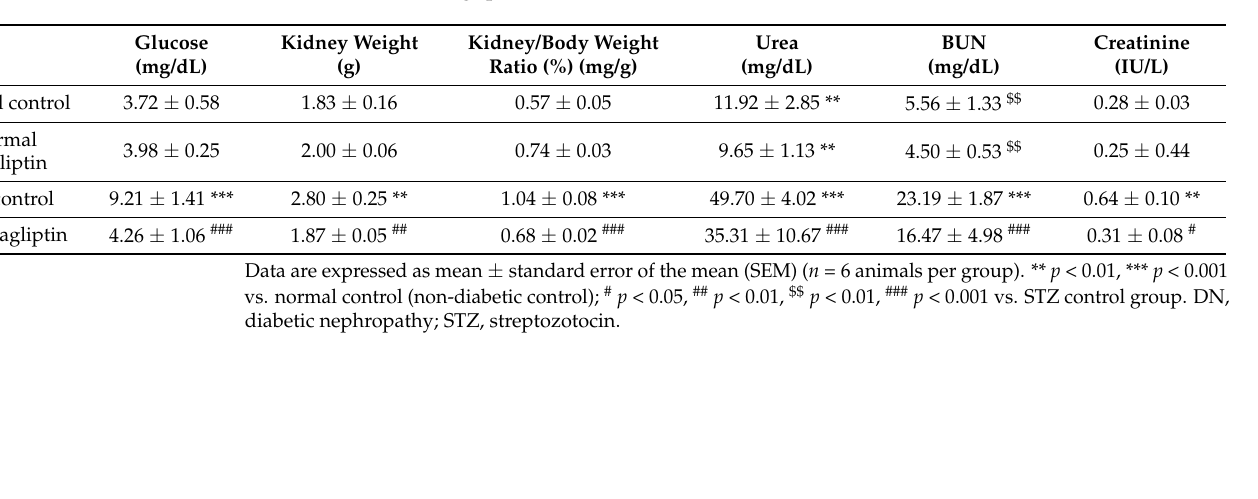
Table 1. Effects of sitagliptin on DN biomarkers in STZ-induced diabetic